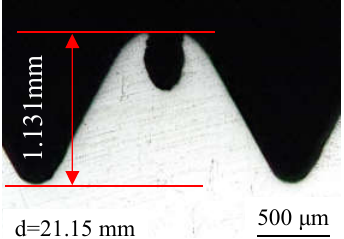
Figure 9. Morphology of machined